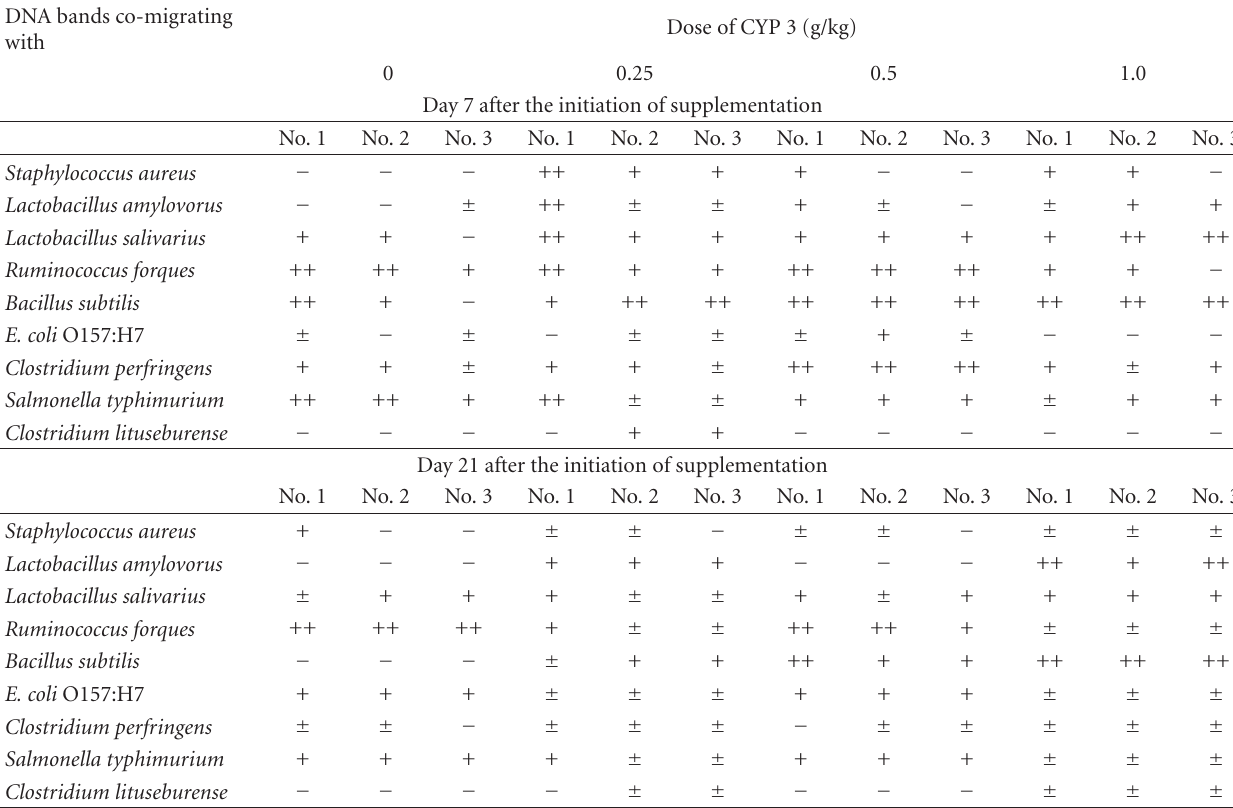
Table 11: E ff ects of Chinese Yam polysaccharide (CYP) 3 on the intestinal bacterial population from cecal digesta in weaned rats ( n = 3). DNA bands co-migrating with